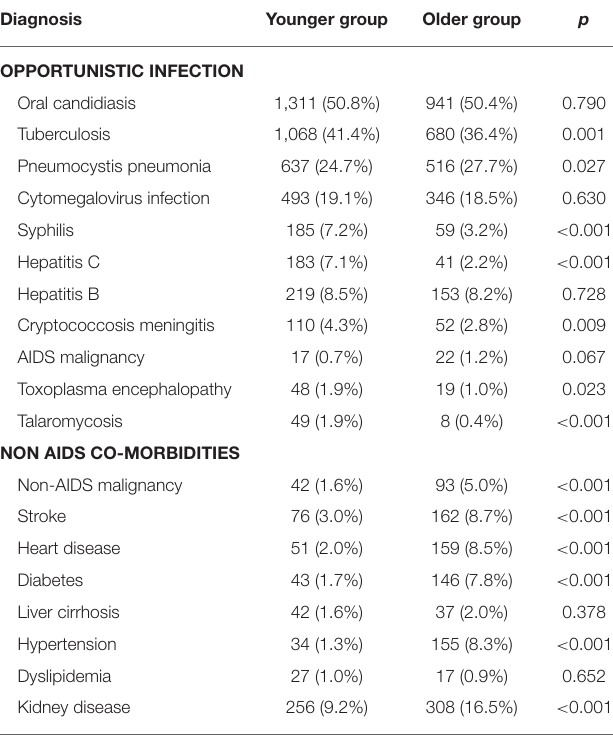
TABLE 2 | Distribution of opportunistic infections and non-AIDS co-morbidities in 4,445 hospitalized PLWH stratified by age.